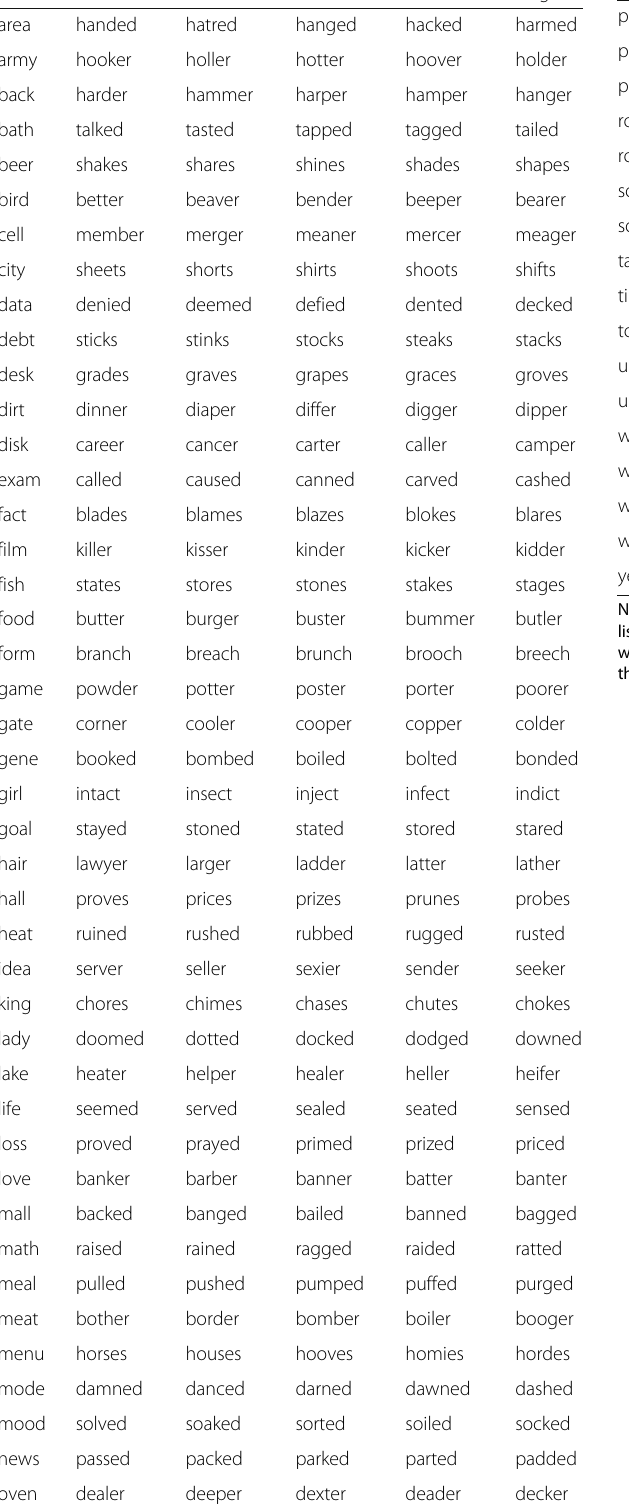
Table 2 Cue-target pairs used in Experiments 1, 2, and 3